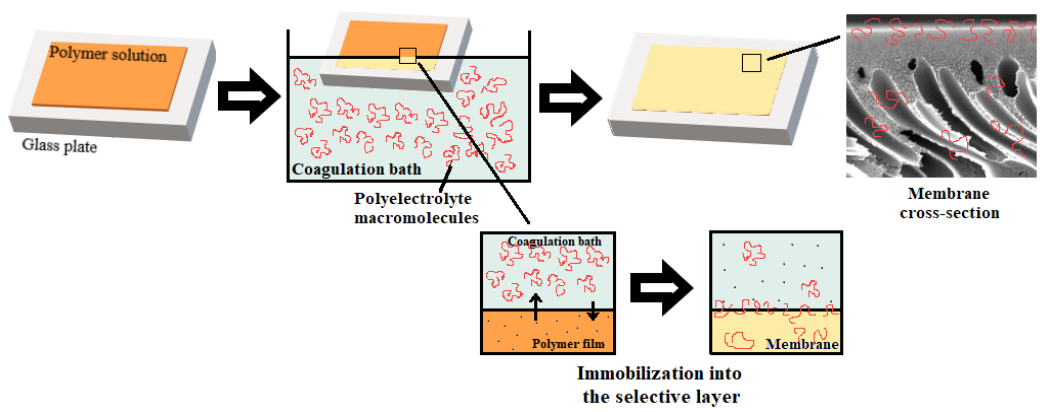
Figure 2. Preparation of membranes by non-solvent induced phase separation (NIPS) using the aqueous solution of polyelectrolyte as a coagulant.